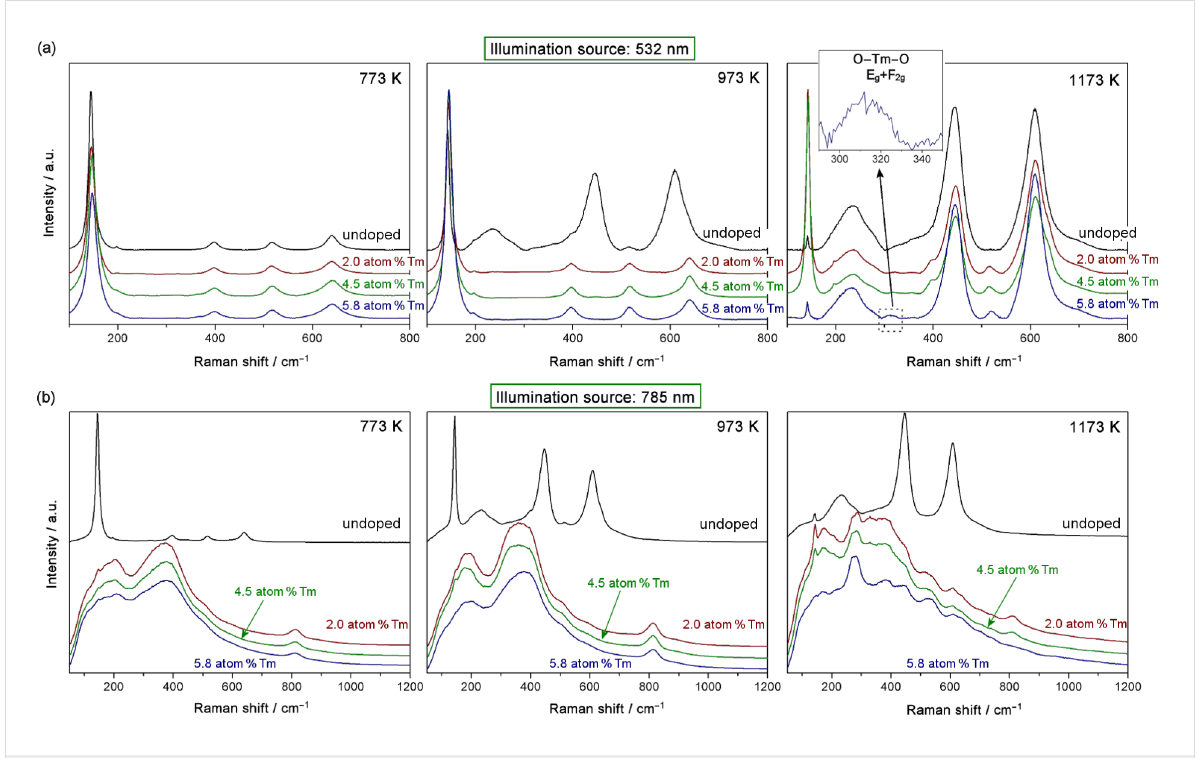
Figure 5: Raman spectra obtained using a 532 nm (a) and a 785 nm (b) illumination source.